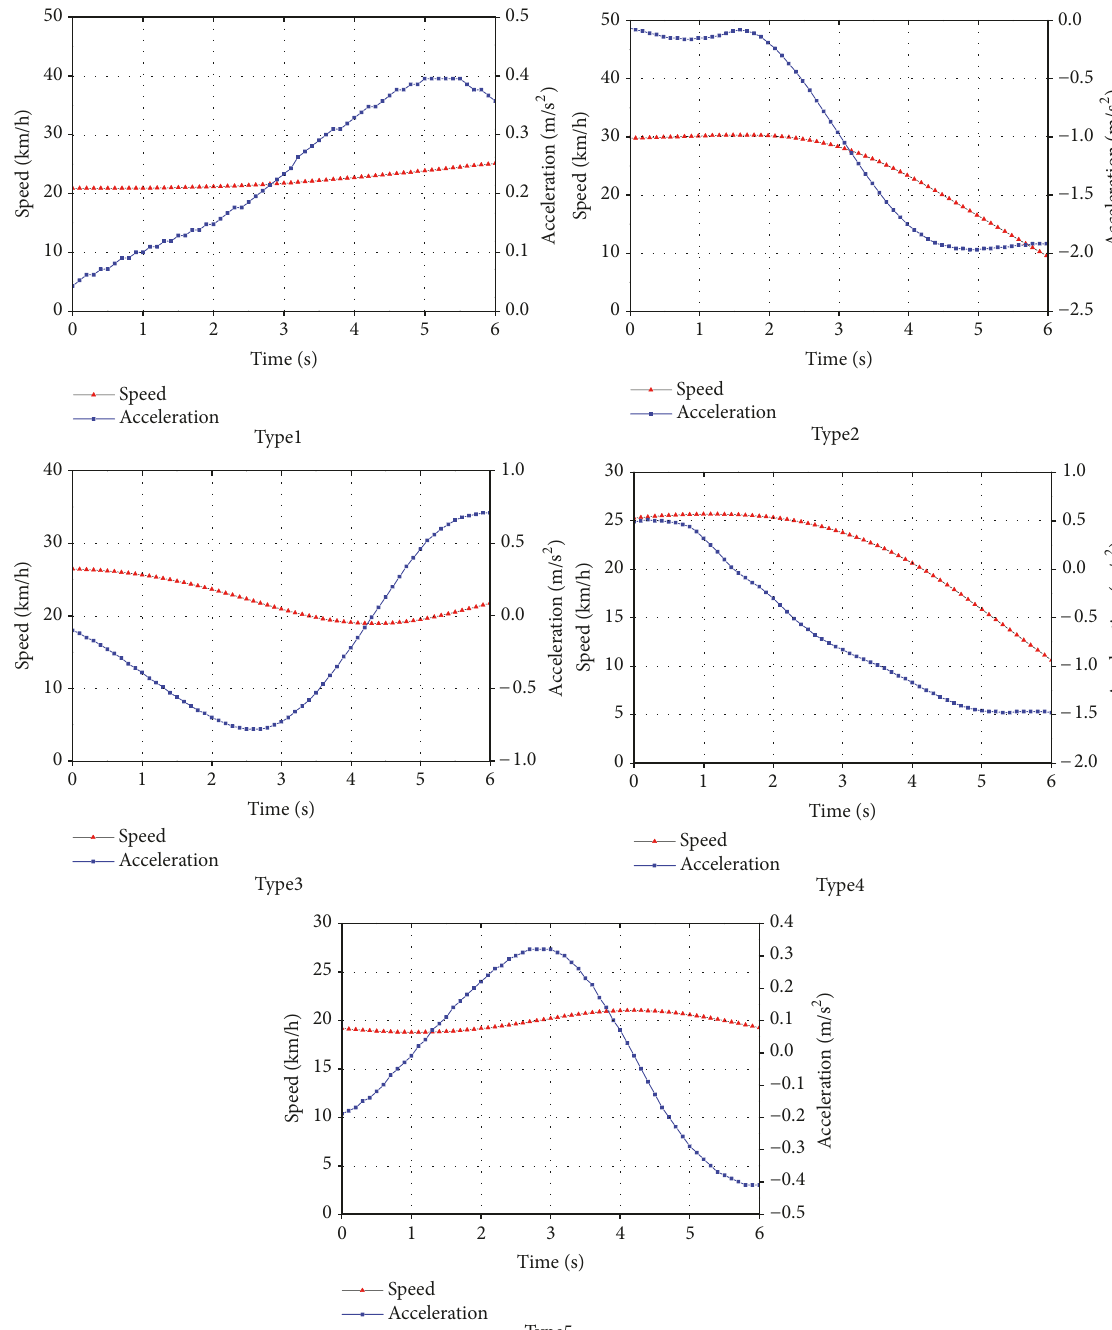
Figure 5: Typical speed and acceleration profiles of each decision type: 1 (pass), 2 (stop), 3 (stop-pass), 4 (pass-stop), and 5 (multiple).